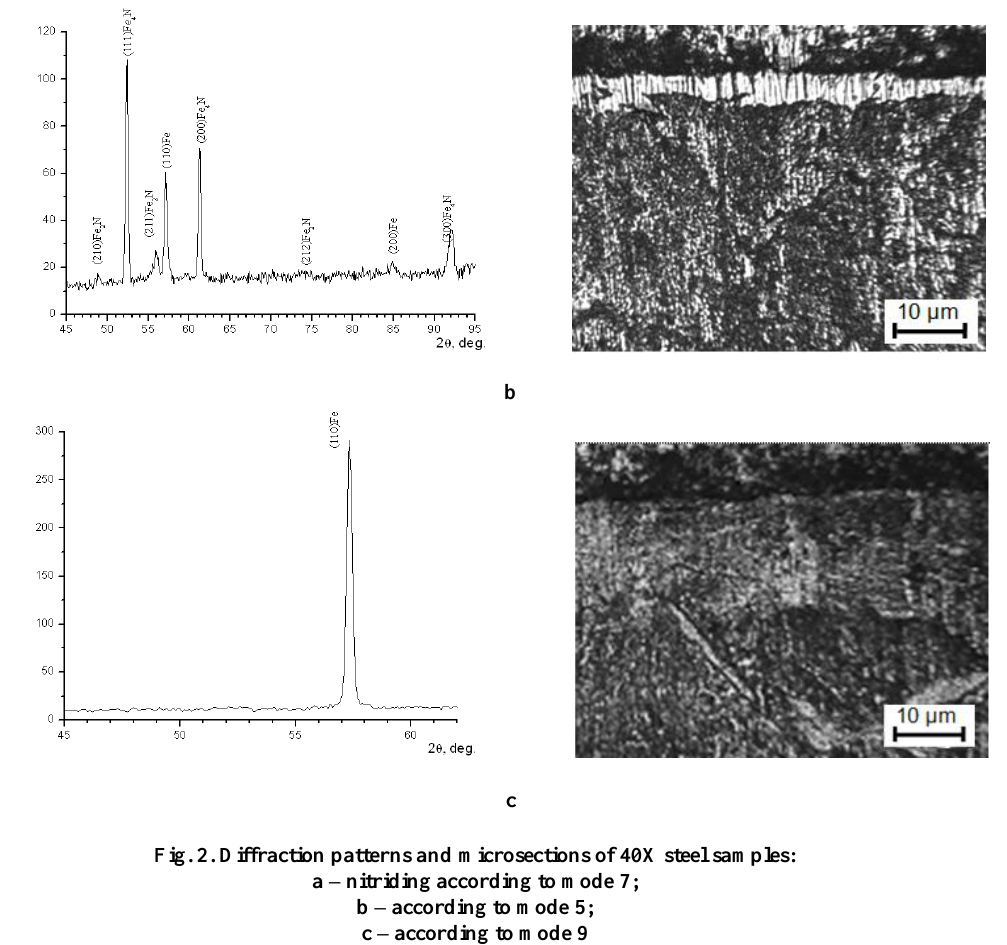
Fig. 2. Diffraction patterns and microsections of 40X steel samples: a – nitriding according to mode 7; b – according to mode 5; c – according to mode 9